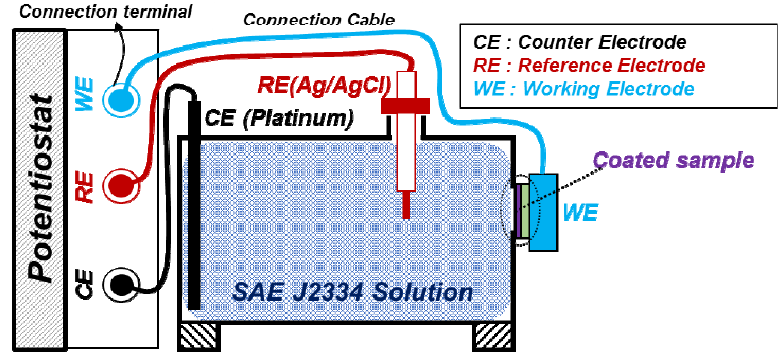
Figure 2. Schematic diagram of the electrochemical setup.